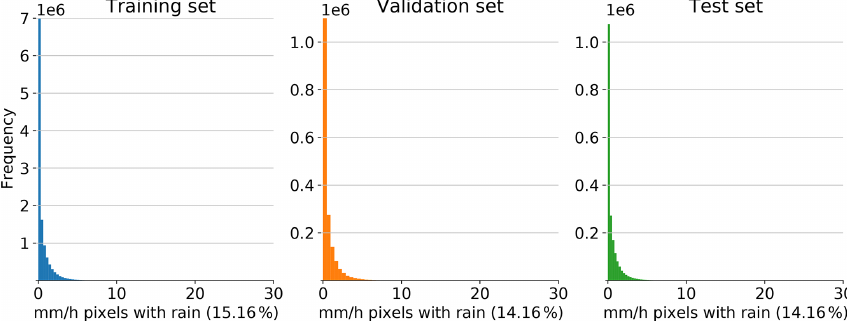
Figure 3. Distribution of registered precipitation for pixels with precipitation > 0mmh − 1 in the radar observations. In all datasets, the majority of the pixels registered no rain. For the pixels with rain, we found the rain amounts to characteristic gamma-like